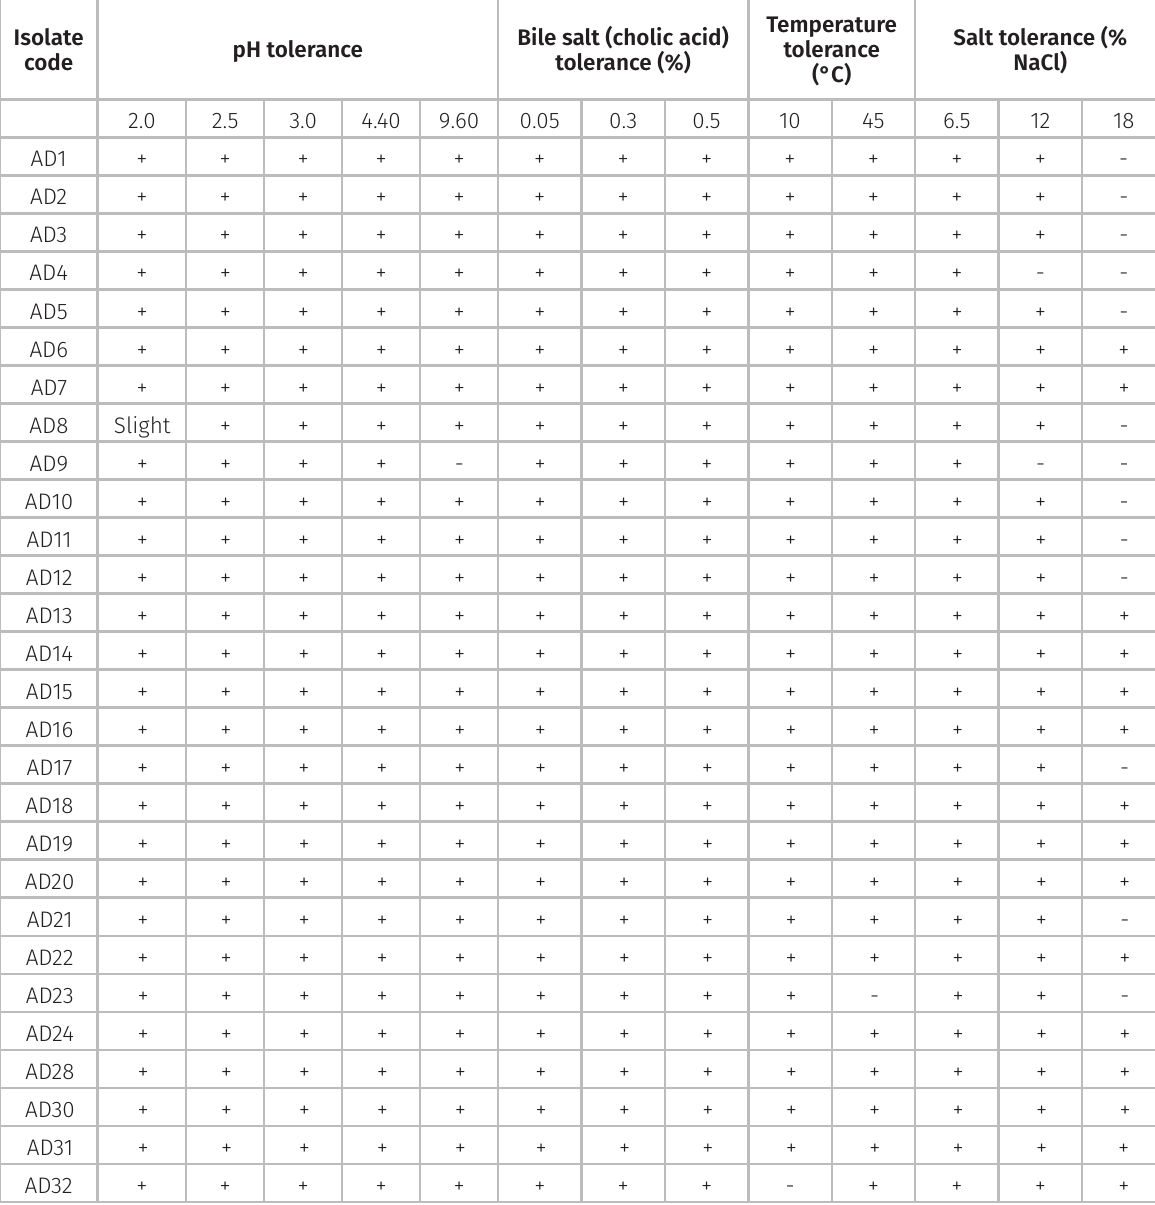
Table V. Phenotypic characteristics (tolerance of pH, bile salt, temperature and salt) of the isolates. Isolate